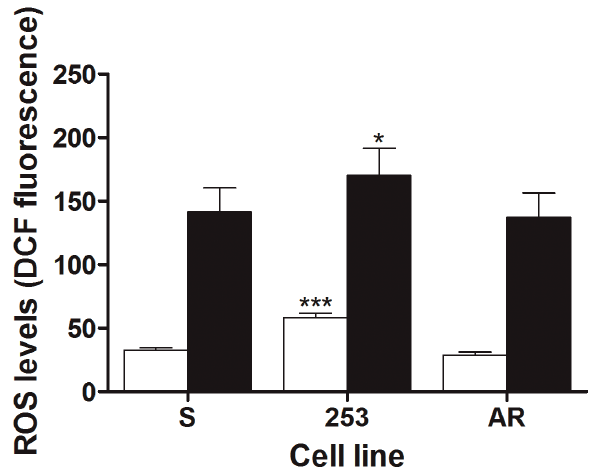
Figure 2. Mean intracellular reactive oxygen species levels in mouse 32D cells transfected with the BCR-ABL1 gene: sensitive (S) and resistant to imatinib expressed as the fluorescence of 2 ′ ,7 ′ -dichlorofluorescein (DCF) oxidatively converted from dichlorodihydrofluorescein diacetate exposed to UV radiation at 35 J/m 2 at room temperature at a dose rate of 0.12 J/(m 2 ·s) (black bars) as compared with non-irradiated cells (white bars). Imatinib resistance resulted from the Y253H mutation in BCR-ABL1 (253) or from incubation of S cells with escalating doses of imatinib (AR). Presented are means of six independent measurements; error bars represent SEM; * p < 0.05, *** p < 0.001 as compared with S line. 2.3. Imatinib-Resistant Cells Have More Pyrimidine Dimers and Oxidative DNA Damage